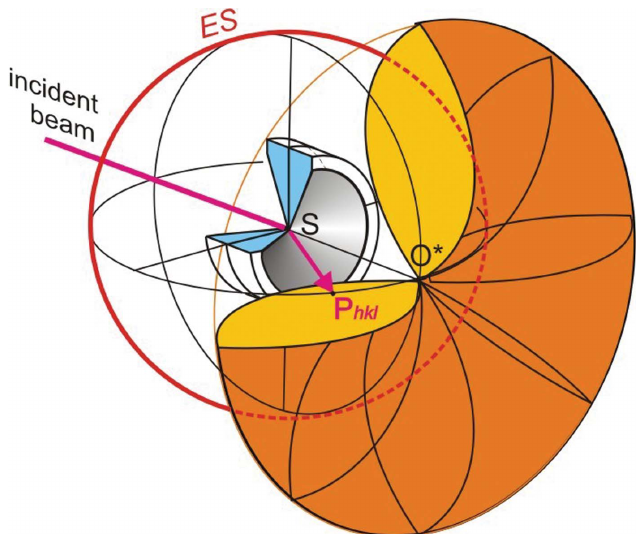
Figure 1 Illustration of accessible reciprocal space through a diamond anvil cell with a conical opening angle (cid:2) . The colored toroidal volume V DAC is given by V DAC = 4 (cid:4) / (cid:5) 3 [sin (cid:2) ( (cid:2) — sin (cid:2) cos (cid:2) )] (Merrill & Bassett, 1974; Miletich et al. , 2000). Tchon´ & Makal (2021) quantify systematically how a sample crystal of given symmetry needs to be oriented relative to the DAC in order to maximize the number of independent reflections in the toroidal volume. Figure modified after Miletich et al. the crystallography community as an on-line tool. And the equally logical but harder to achieve step after that is to develop a set of micromanipulation tools in conjunction with orientation photographs of the sample to achieve the perfect sample orientation of a ~100- m m crystal on a diamond culet of slightly larger dimensions. This for the time being is still reliant